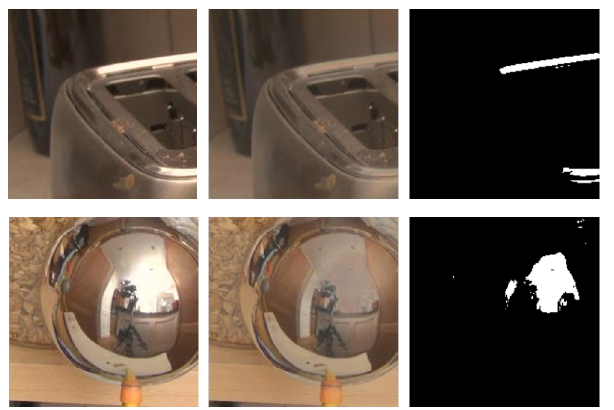
Fig. 1 Specular highlight removal and detection results from our method. Left: input images with specular highlights. Middle: after highlight removal. Right: detected